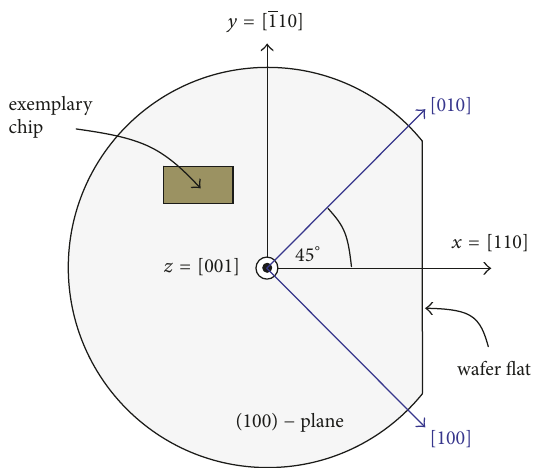
Figure 1: Reference frame ⟨100⟩ of the single crystal and chip reference frame Σ = (𝑥,𝑦, 𝑧) for a (100)-silicon